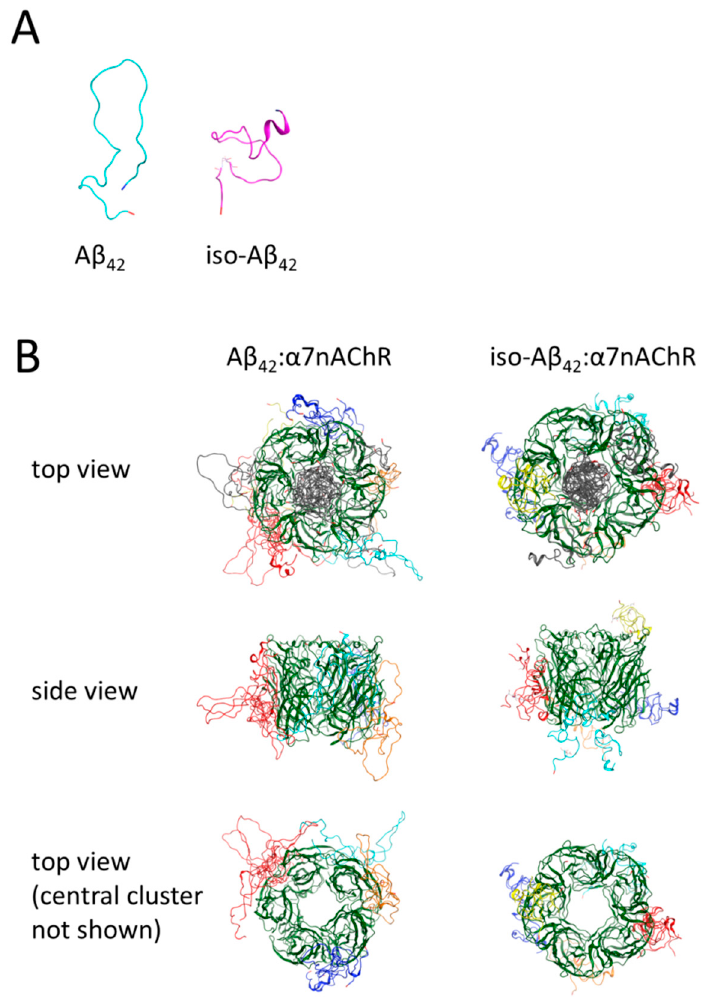
Figure 4. ( A ) Models of A β 42 and iso-A β 42 in solution. ( B ) Models of the α 7nAChR complexes with the amyloid peptides.